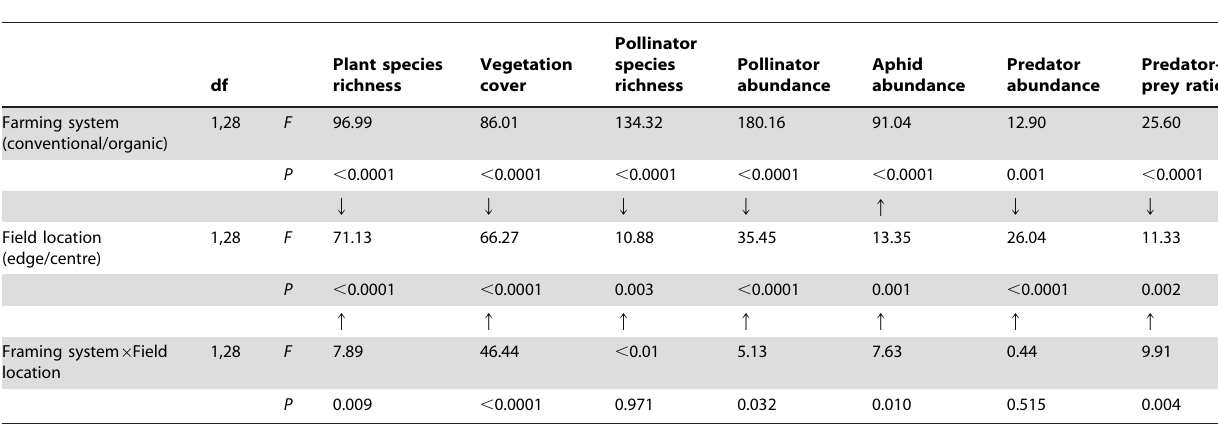
Table 3. Mixed effects model statistics of the seven response variables with the explanatory variables farming system, field location and the interaction of farming system and field